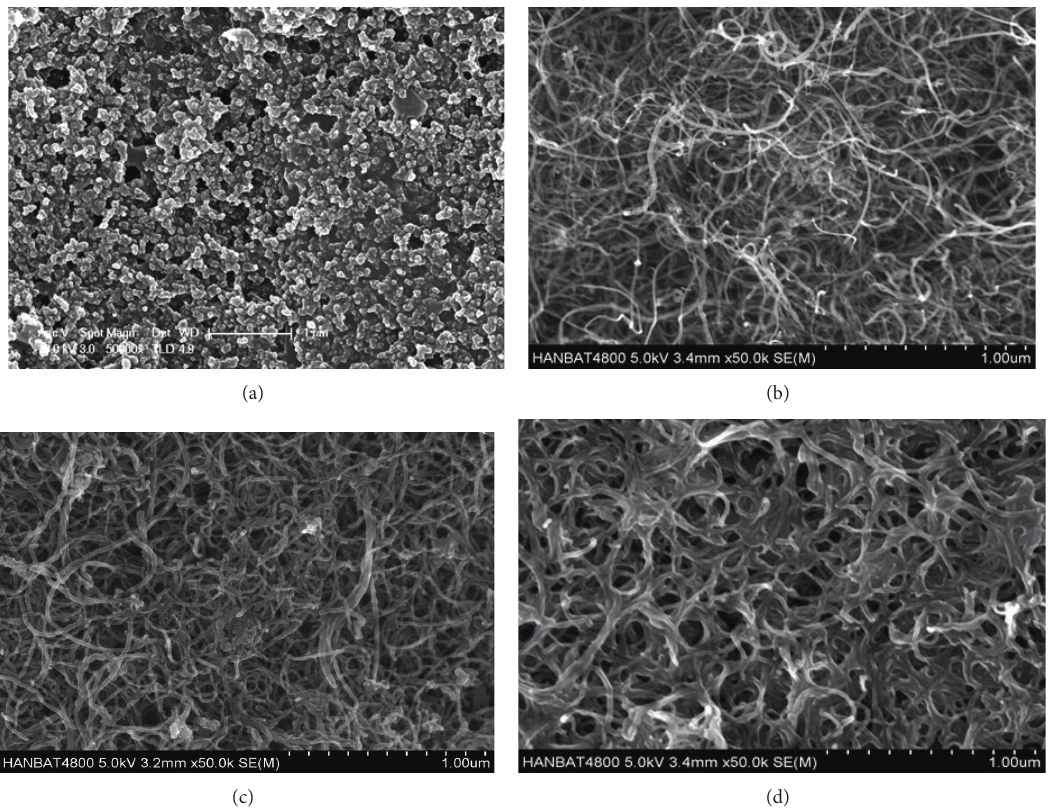
Figure 4: SEM images of the bare SPE (a), MWNT-modified SPE (b), COOH-modified SPE (c), and AChE-ChOx-modified SPE (d).